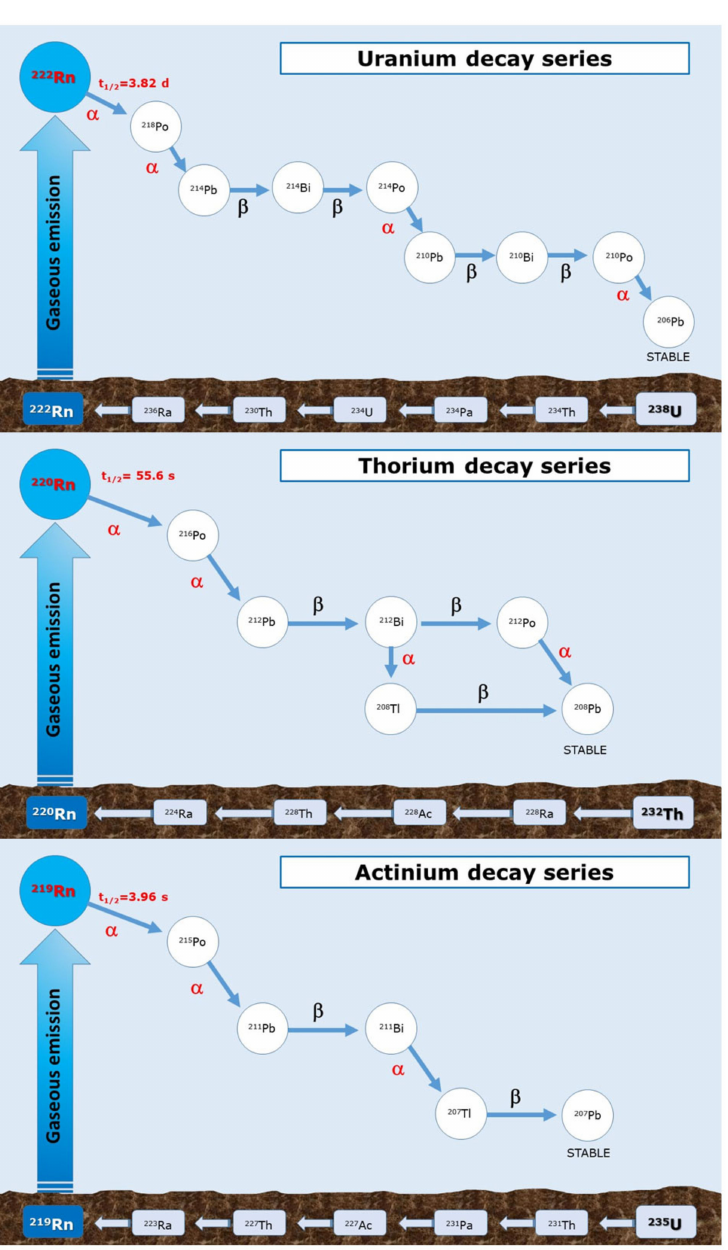
Figure 1. Decay series of Uranium, Thorium, and Actinium. Pa = Protactin, Ac = Actinium, Ra = Radium, Tl =